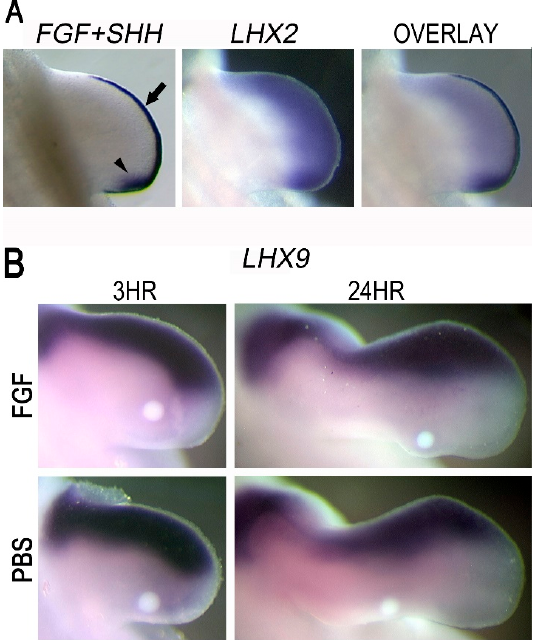
Figure 5. The LHX2 expression pattern supports a role for maintaining distal posterior SHH expression during progressive limb outgrowth. ( A ) Left panel shows endogenous FGF8 (arrow) and SHH (arrowhead) expression in a HH23 limb bud. Middle panel shows endogenous LHX2 expression. Right panel is a composite of all three expression patterns. LHX2 expression is restricted to the distal mesoderm in the developing limb subjacent to the FGF8 -expressing AER. Importantly, SHH is expressed only within the posterior boundary of the LHX2 expression domain. The overlapping expression pattern is consistent with a role for LHX2 in facilitating SHH expression in the developing limb. ( B ) After 3 and 24 h of FGF2 exposure, no appreciable ectopic LHX9 expression is observed (n = 3 embryos per treatment group for each time point). PBS beads were used as controls. Note that endogenous LHX9 expression is restricted to the anterior mesoderm.